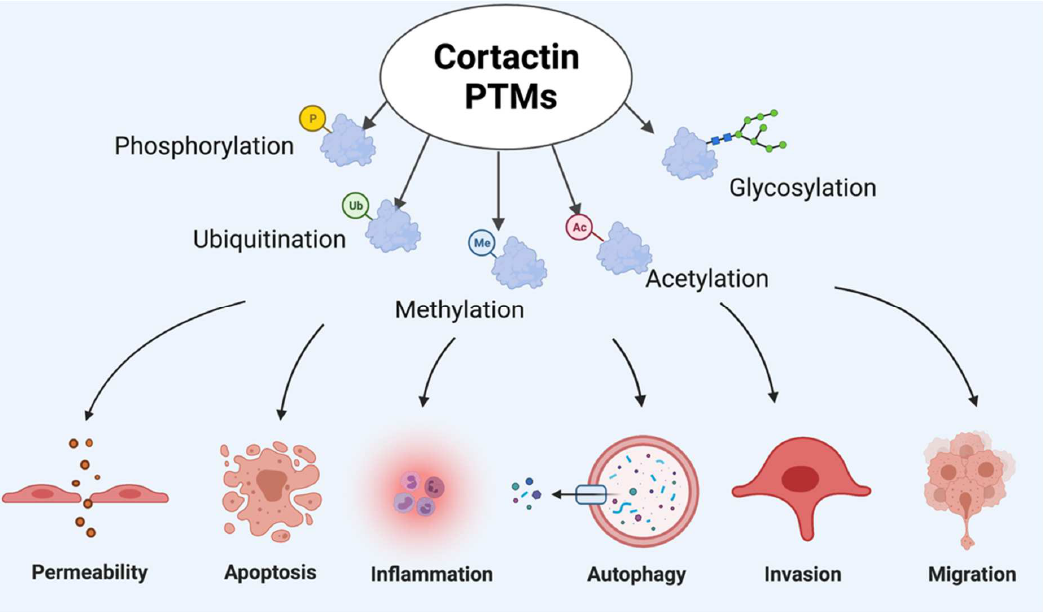
Figure 2. Cortactin post-translational modifications (PTMs) participating in endothelial cell patho- physiologic responses.